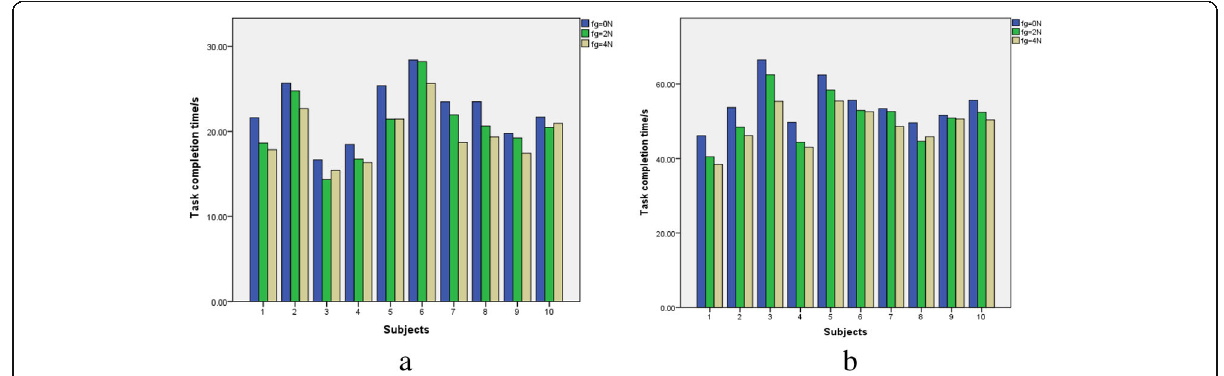
Fig. 9 Task completion time histogram in two different scenarios. a Virtual robotic scenario. b Ball tracking